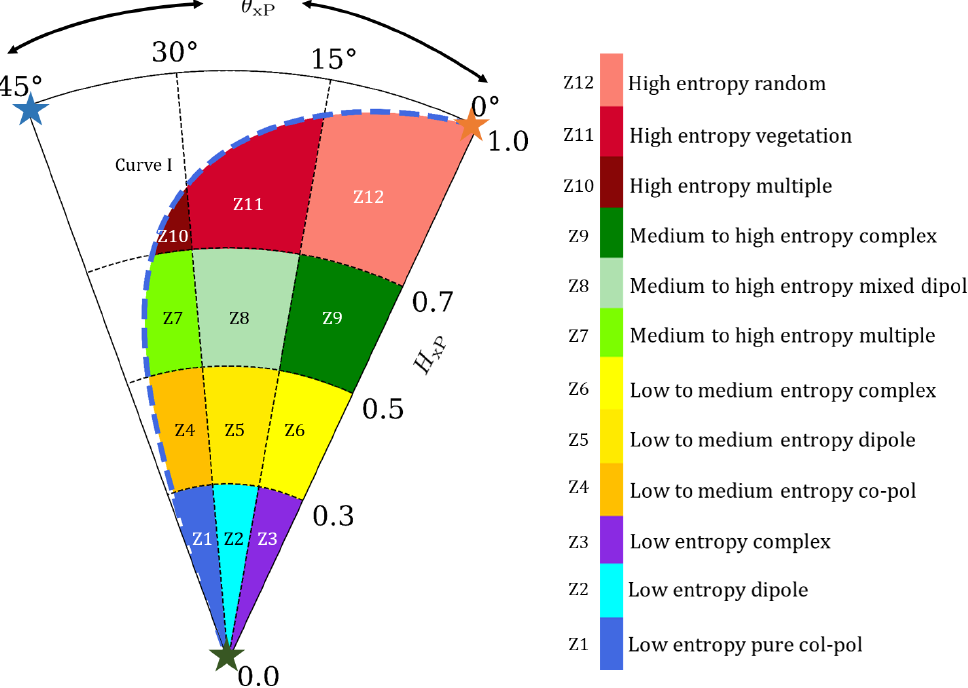
Figure 5. Twelve clustering zones in the H xP / θ xP